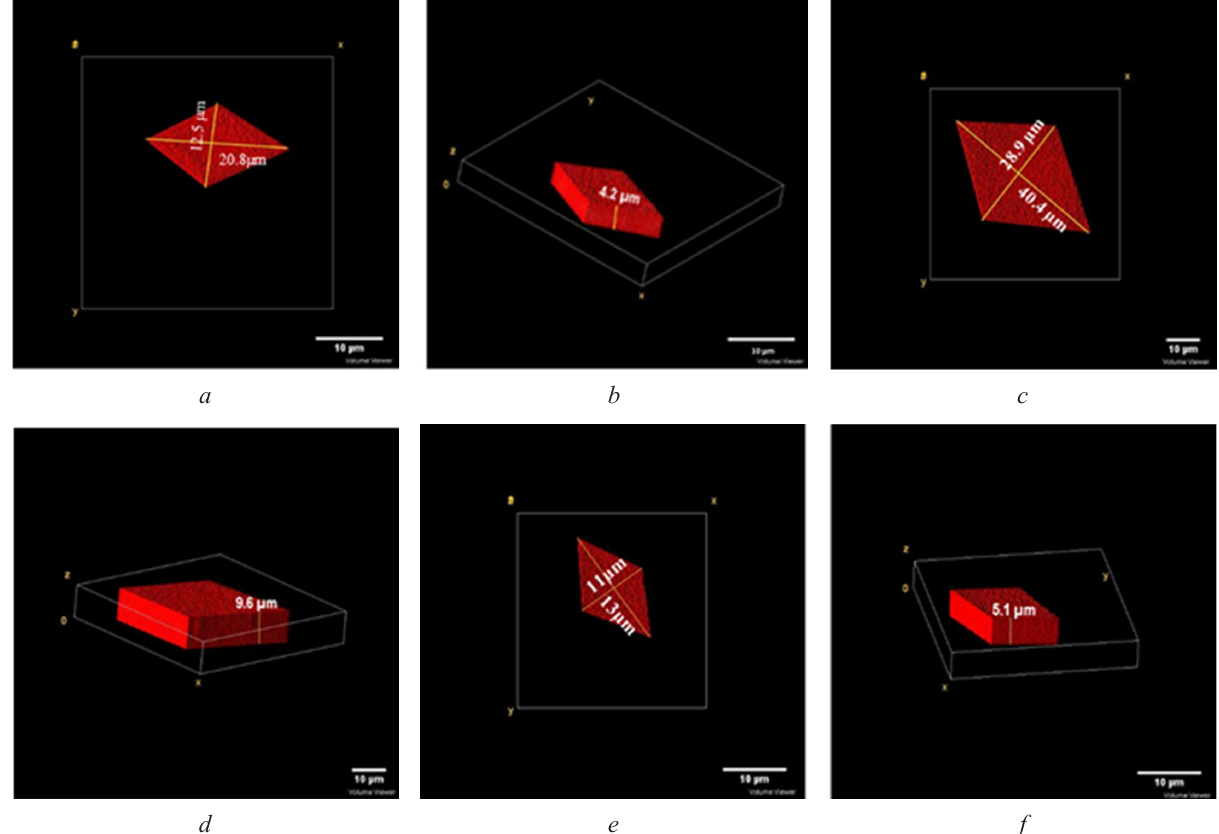
Fig. 3. Confocal microscope images of MDN crystals (magnification of ×40), showing the dimension values of MDN crystals: a, c, e – the aerial views of MDN crystals length and width; b, d, f – thickness measurements of MDN